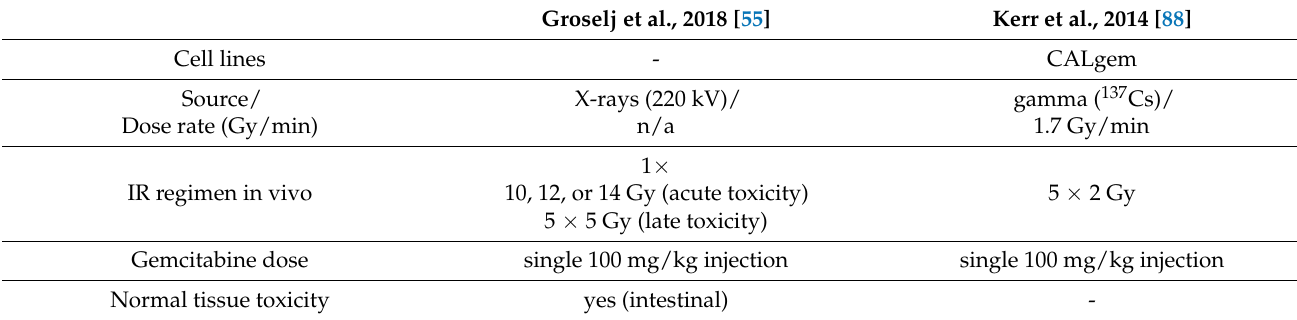
Table 6. Overview of studies using Gemcitabine in BCa preclinical studies in combination with